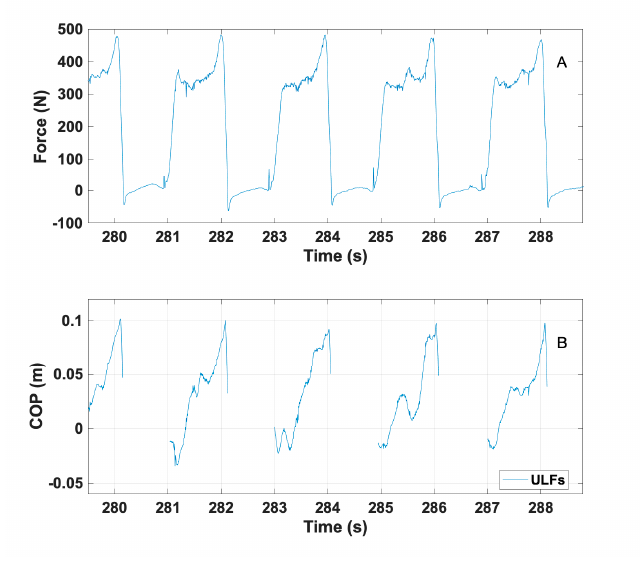
Figure 4. Example of ( top ) total force measured with the ultra-light force sensors, front and rear output combined, and ( bottom ) the center of pressure (COP) along the blade of the